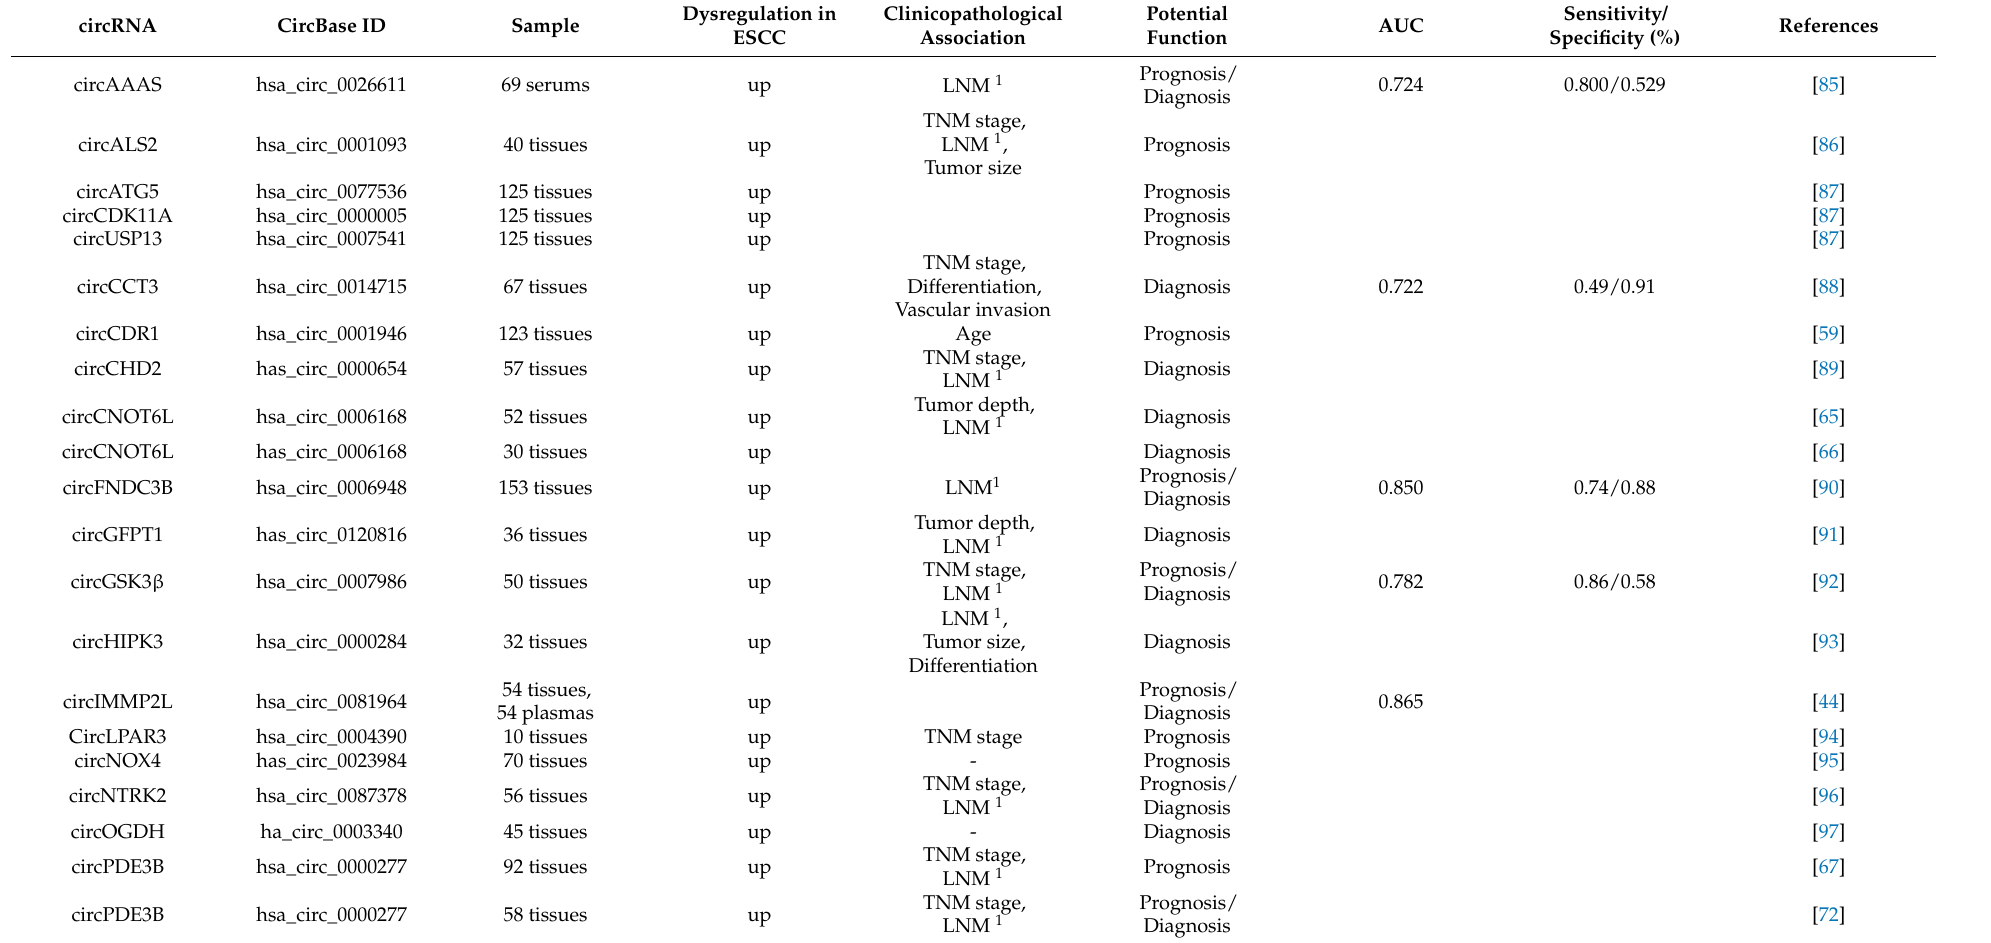
Table 1. Circular RNAs (circRNAs) as diagnostic and prognostic biomarkers for